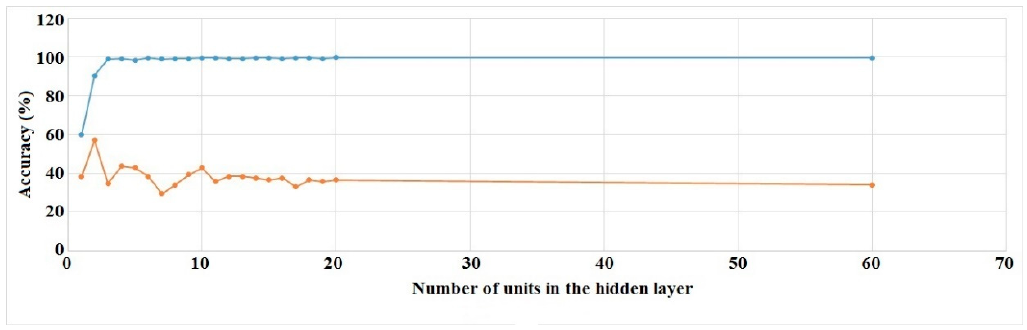
Figure 11. ANN training (blue) and validation set (red) accuracies for different number of units in the hidden layer (LH, user specific).